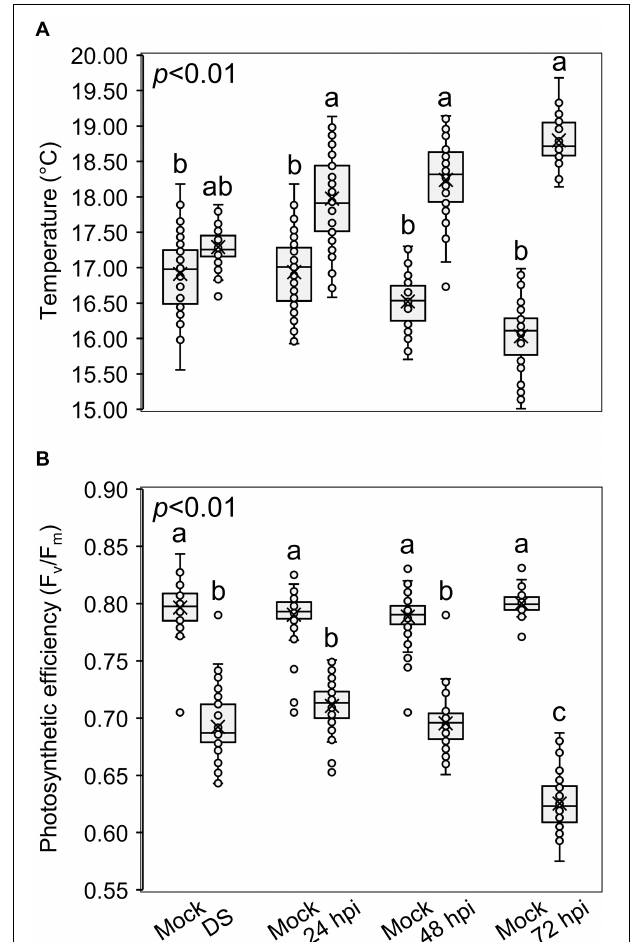
FIGURE 5 | (A) Fusarium head blight (FHB) severity (%) in Triticum turgidum (cv. Marco Aurelio) from 3 to 21 days post inoculation (dpi) during the greenhouse experiments. (B) FHB symptoms in T. turgidum at 21 dpi. The data was derived from the averages and standard errors of three treatments